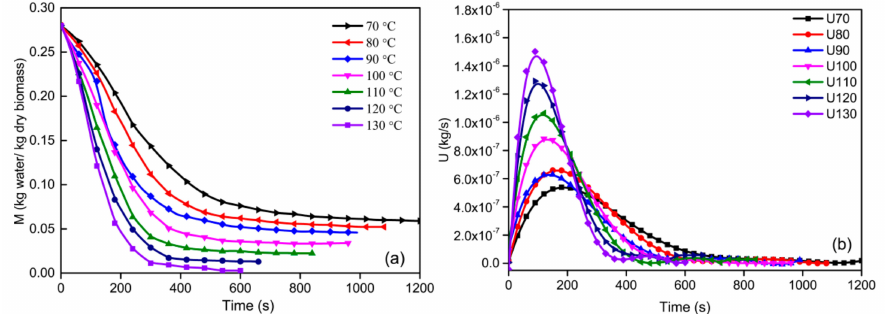
Figure 2. Effects of dying temperature on biomass drying process: ( a ) drying curves; ( b ) drying rate